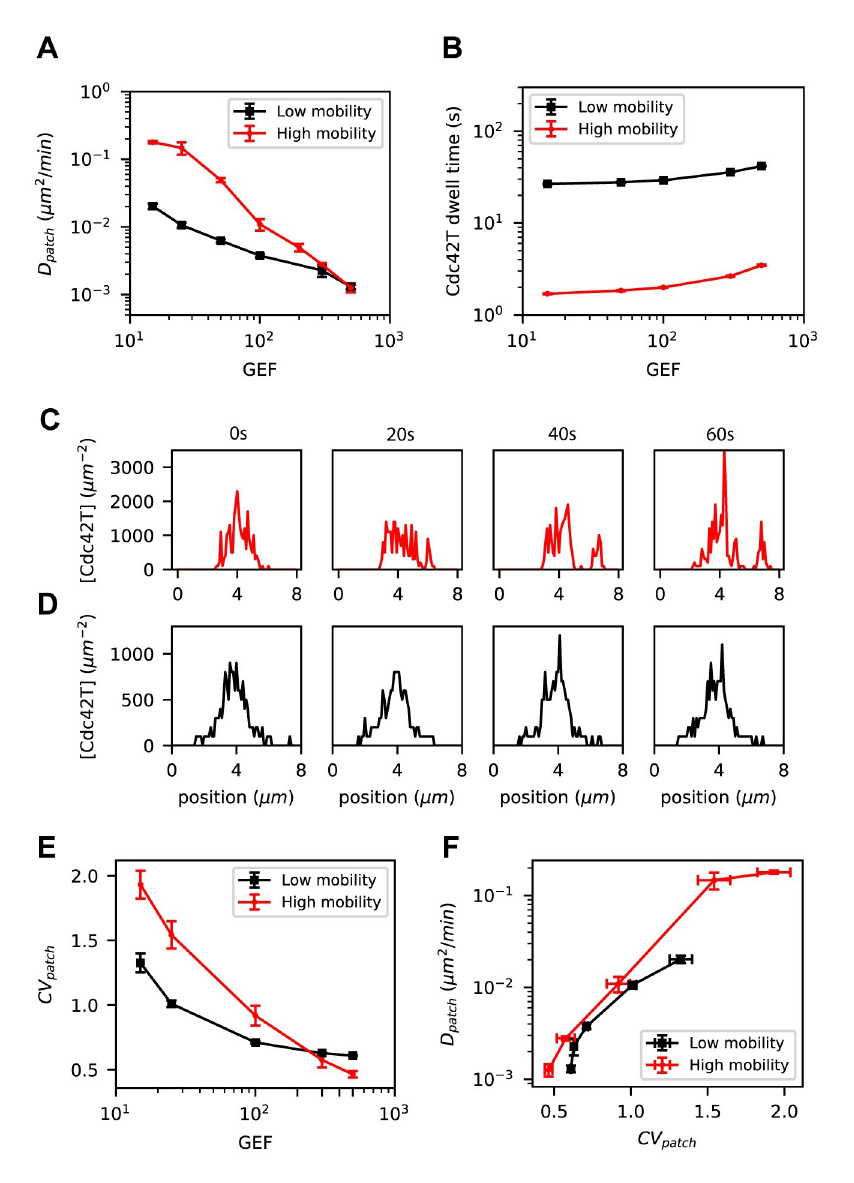
Fig 6. Cluster mobility correlates with fast distribution fluctuations and short dwell times of Cdc42T. Comparison of a “Low mobility” model (from Fig 5C) and a “High mobility” model (from Fig 5G). (A) Patch centroid diffusivities, (B) dwell time of Cdc42T at the cluster, (C) Snapshots of the lateral profile of the concentration of total Cdc42T molecules for the High mobility model and (D) Low mobility model. (E) Coefficient of variation of the distribution of total Cdc42T molecules, CV (see Methods), as a function of the number of total GEF molecules. (F) Patch centroid patch diffusivity as a function CV patch for the Low mobility and High mobility models. Error bars for patch centroid diffusivities are standard errors from the least-squared fit used to compute D . For all other quantities, the error patch bars are the standard deviation from estimations in 5 independent